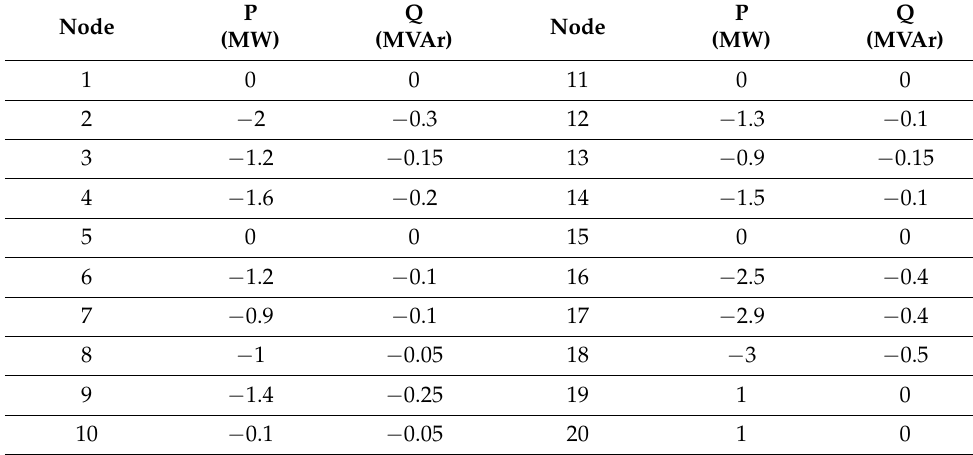
Table 3. Node parameters.